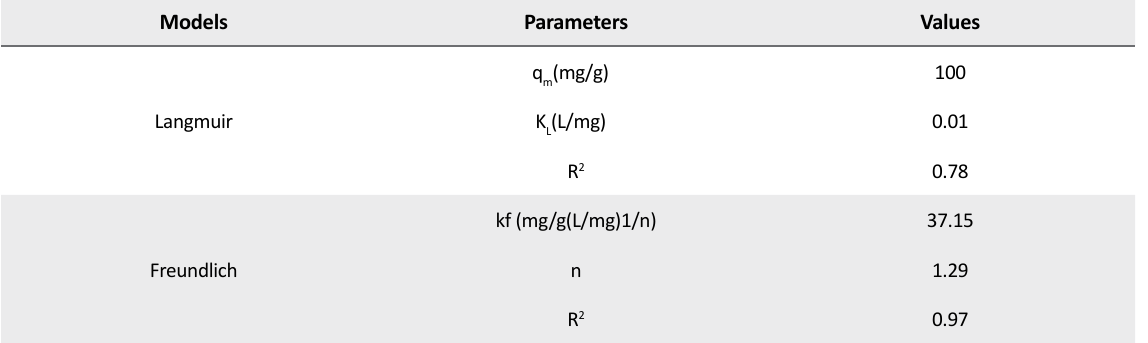
Table 2. Isotherm parameters of methyl orange adsorption by the adsorbent